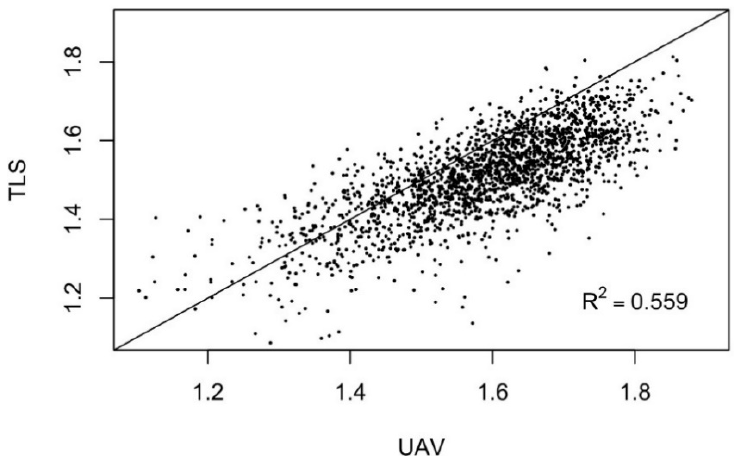
Figure 6. Relationship between the box dimension (D b ) values measured with terrestrial laser scanning (TLS) and unmanned aerial vehicle (UAV). The coefficient of determination (R 2 ) is 0.559.